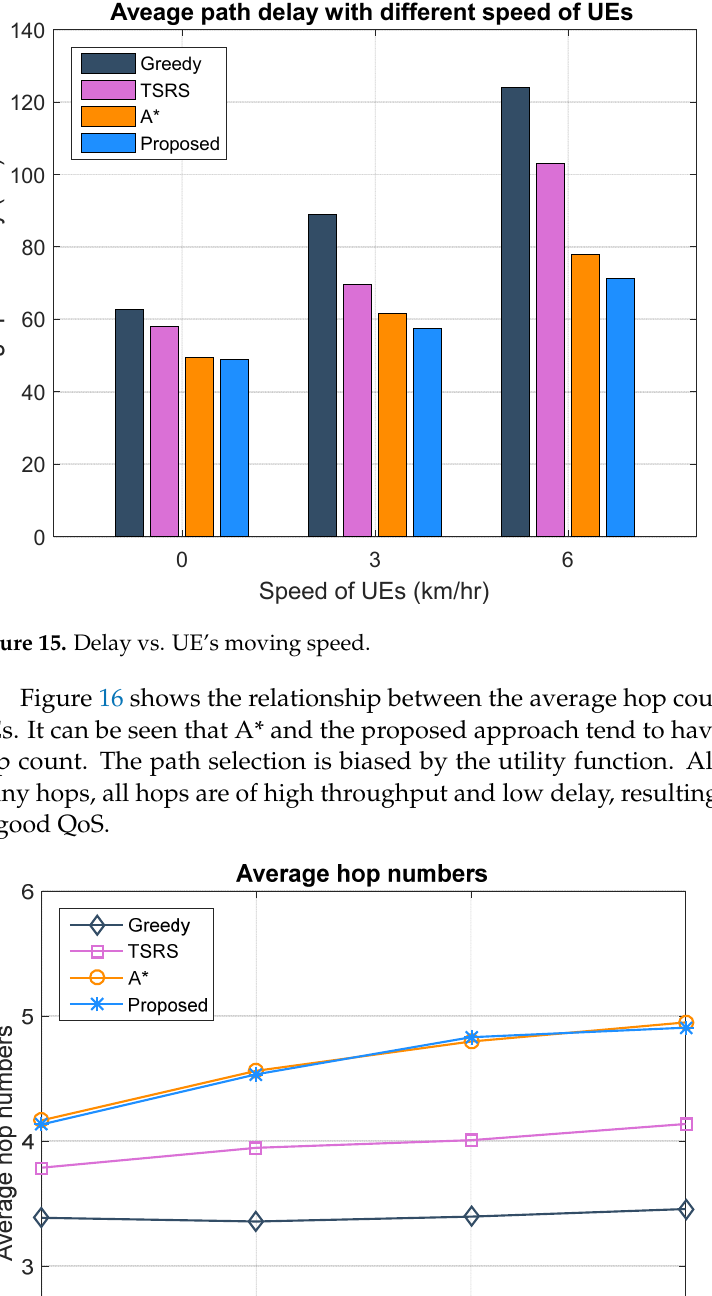
Figure 14. Delay vs. number of UEs.